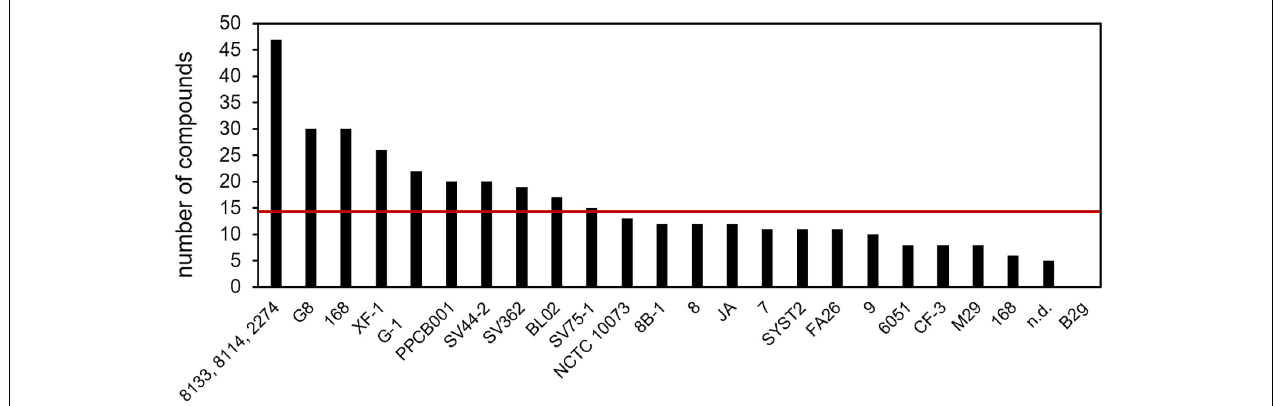
FIGURE 1 | Detected compounds per B. subtilis isolate. Volatile secondary metabolites emitted by 26 B. subtilis isolates were summarized from 20 original scientific publication (see Table 1 ). n.d., isolate was not defined; red line is the arithmetic average of 14; B. subtilis 168 was analyzed twice; the results of 8133, 8114, and 2274 are aggregated in the original